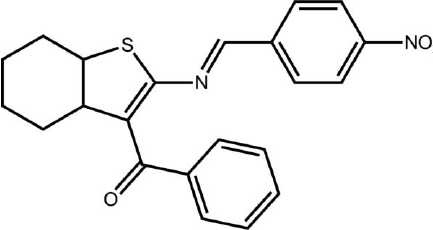
Data collection Agilent Eos Gemini diffractometer Absorption correction: multi-scan